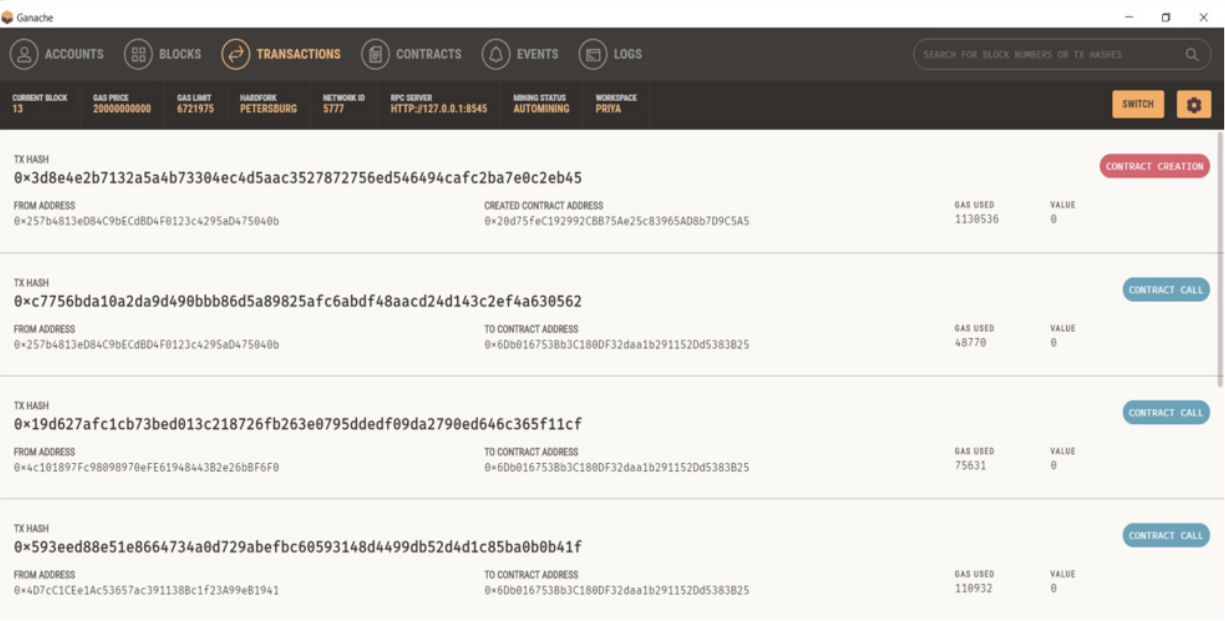
Figure 5. Blocks information in Ganache. Author Contributions: R.C.: data curation, methodology, writing—original draft; J.K.D.: literature review, writing—review and editing; T.R.G.: formal analysis, writing—original draft, supervision; C.I.: methodology, writing—review and editing, supervision. All authors have read and agreed to the published version of the manuscript. Funding: This research received no external funding.